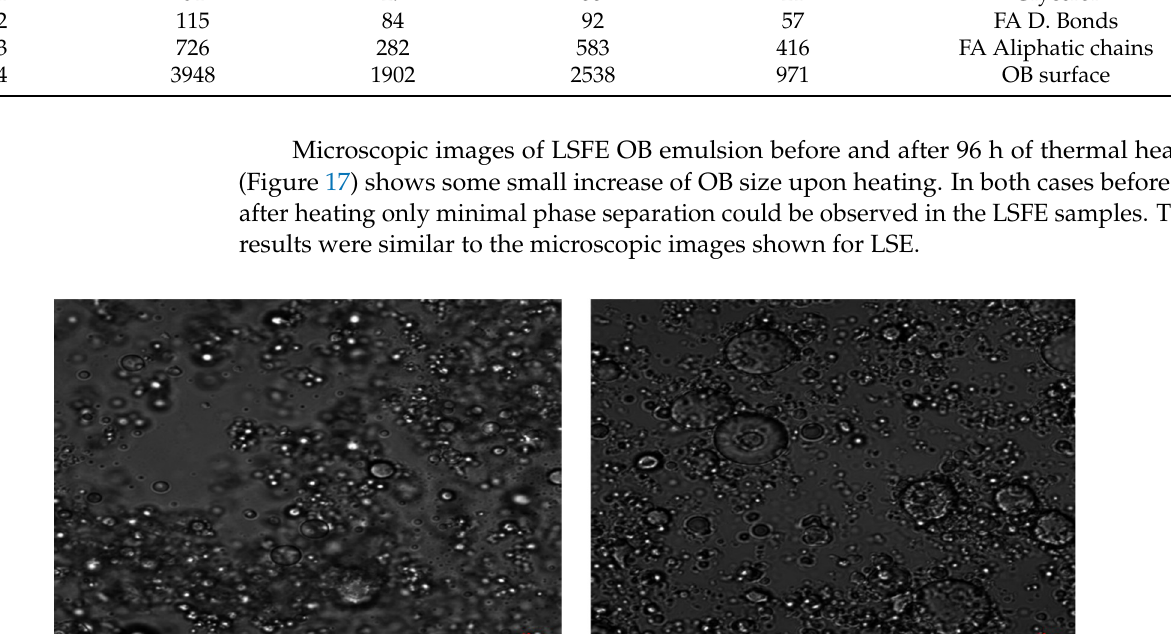
Table 4. Two-dimensional T 1 -T 2 peaks values of LSFE and proposed 1 H TD assignment. Table 4. Two‐dimensional T 1 ‐T 2 peaks values of LSFE and proposed 1 H TD assignment. Peak